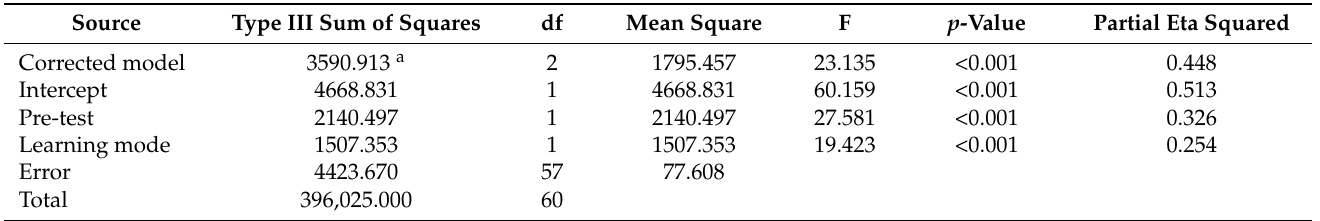
Table 3. The result of ANCOVA on health knowledge. Dependent variable: post-test on health knowledge.